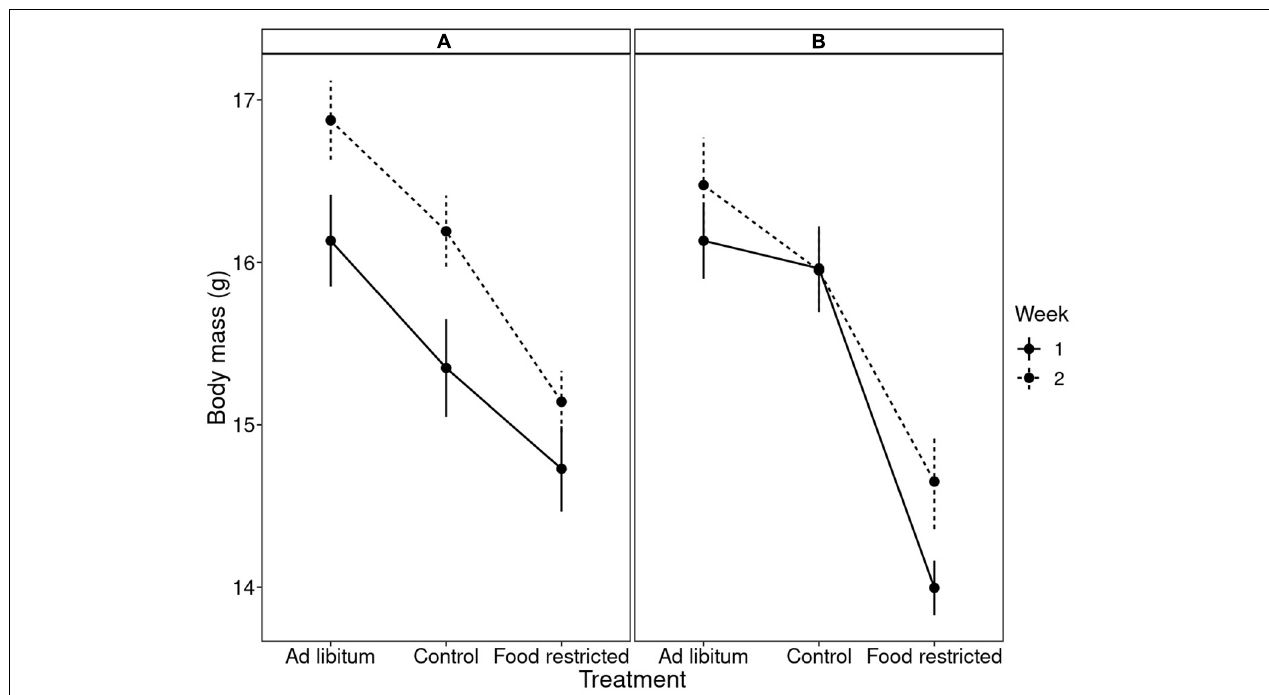
FIGURE 2 | Mean ± SE body mass in bearded reedlings after different dietary treatments. The x -axis shows the type of dietary treatments while the two panels show in which order the birds received these treatments (see also Supplementary Figure 1 ). (A) Indicates control diet followed by restricted diet, and (B) means restricted diet followed by control diet. Solid and dashed lines indicate week 1 and 2 of the experiment, respectively. Note that body mass variation was affected by treatment, week, the order of treatments and the treatment × order interaction.